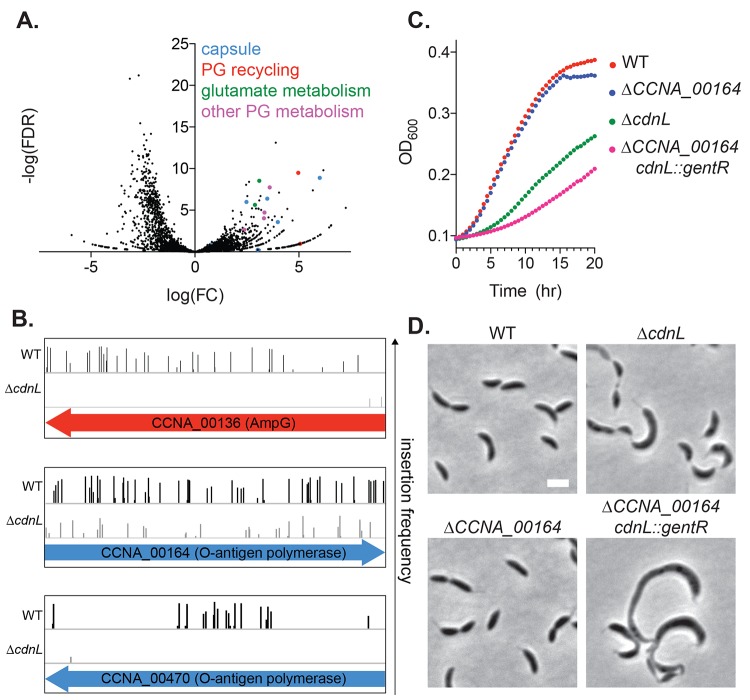
Mutations in cell wall recycling and capsule biosynthetic genes are synthetic lethal with ΔcdnL.A. Volcano plot representation of Tn-seq analysis. Negative log10 of the false discovery rate (-log(FDR)) is plotted against log2 of the fold change in number of unique transposon insertions in each gene in WT (EG865) vs ΔcdnL (EG1447). Genes that become essential in the ΔcdnL background and are discussed in this study are color-coded. B. Transposon insertion profile for selected genes from A. C-D. Growth curves and phase contrast images for WT (EG865), ΔcdnL (EG1447), ΔCCNA_00164 (EG2604) and ΔcdnL ΔCCNA_00164 (EG2804). Bar = 2 μm.